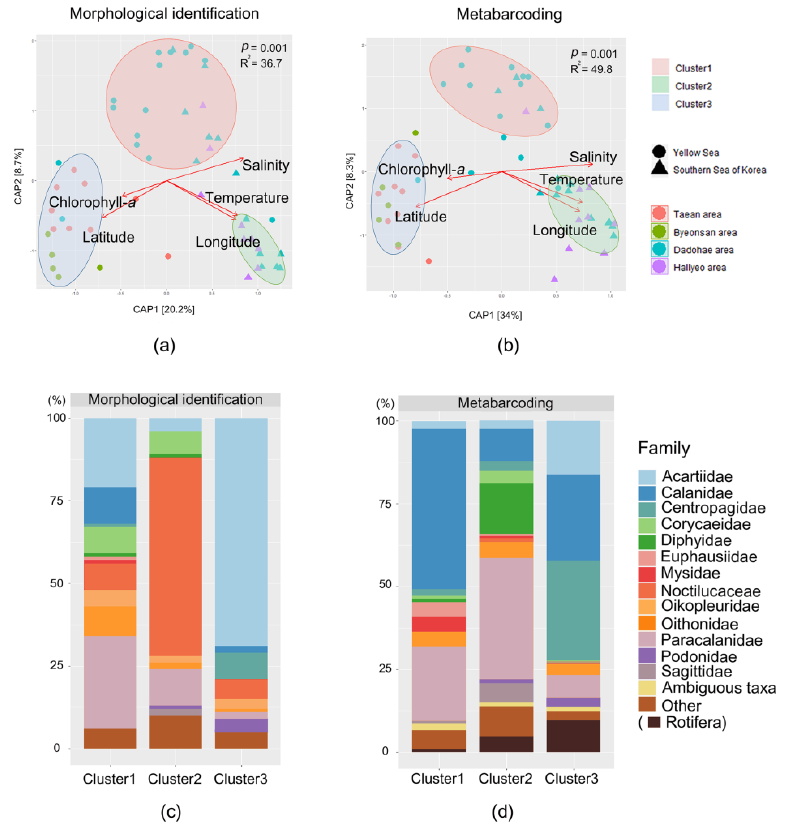
Figure 6. The association between spatial, environmental characteristics and mesozooplankton communities. CAP analysis for zooplankton communities based on Bray–Curtis dissimilarities according to each category and identification method: ( a ) spatial and environmental variables, and morphological identification; ( b ) spatial and environmental variables, and metabarcoding. The arrows on the CAP plots in (a) and (b) indicate the patterns in response to the spatial and environmental variables for the zooplankton community clusters. Bar plots between zooplankton community clusters formed using ( c ) morphological identification and ( d ) metabarcoding according to spatial and environmental variables in CAP